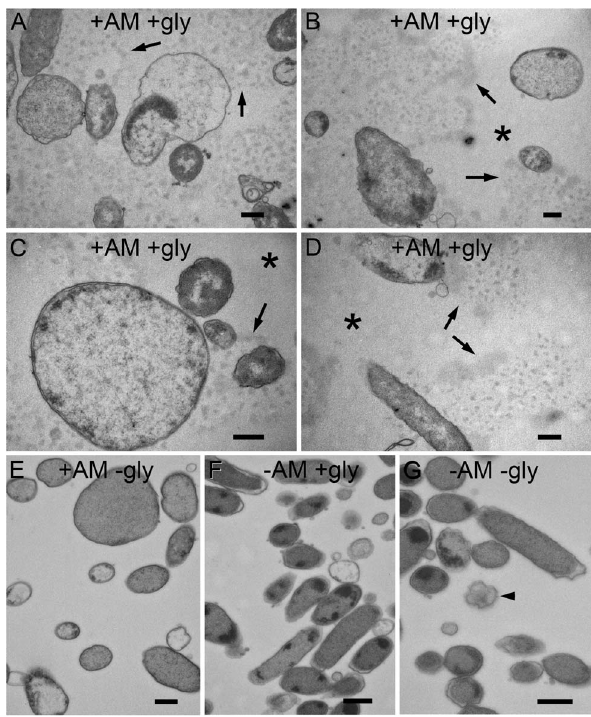
Figure 9. Ultrastructural visualization of glycogen in PittGG biofilms. Resin-embedded thin sections of PittGG biofilms formed in the presence or absence of ampicillin ( + / 2 Am) and treated with a glycogen stain or a no stain control ( + / 2 gly). A–D Biofilms with ampicillin, sections stained for glycogen (periodic acid and sodium chlorite). The glycogen stain reacted with an extracellular granular substance (arrows) that was associated with biofilm bacteria. Exposure to antibiotic resulted in a bacterial size increase with some bacteria (A– C). Extracellular areas that were not in close proximity to bacteria cells (asterisk) did not contain the extracellular granular substance (B–D). E. Biofilm with antibiotic but only treated with sodium chlorite did not reveal extracellular granular substance. Large bacterial cells were present. F. Biofilm with no antibiotic, sections stained for glycogen. No extracellular granular substance was detected and bacterial cells had a normal diameter (approx. 500 nm). Some lysed cells were detected. G. Biofilm with no antibiotic, treated with sodium chlorite (no periodic acid). Bacterial cells appear normal with a few dying cells present (arrowhead). Scale bars=500